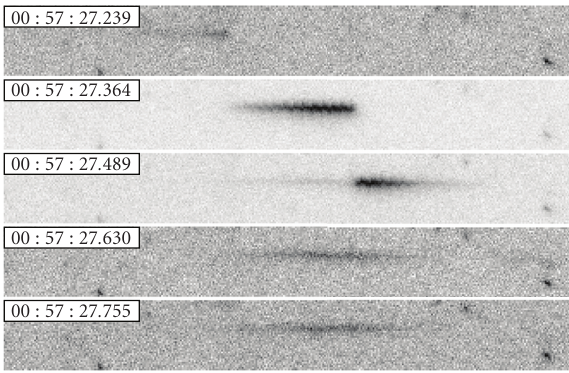
Figure 8: Example of a fast (flight time approximately 0.3 seconds) and bright ( V peak ≈ 3) meteor detected by the FAVOR camera. Sub- frame brightness variations, as well as long-lasting trail, are clearly